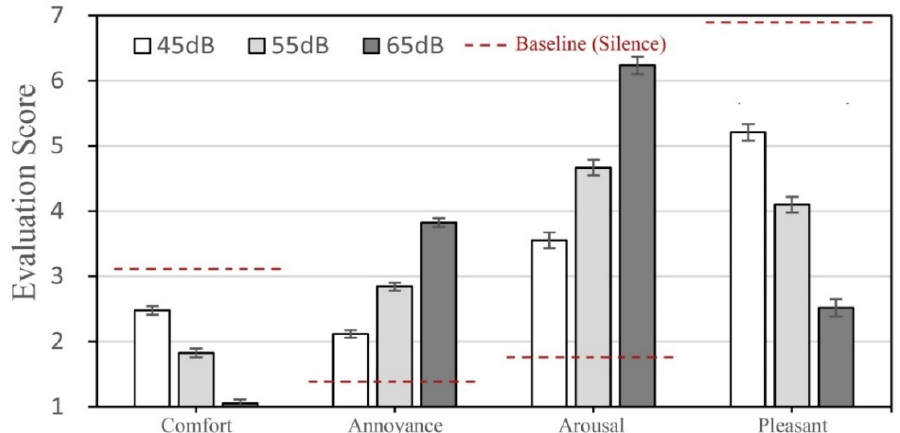
Figure 5. Effect of sound level on psychological responses. The vertical bar represents 95% confidence interval.